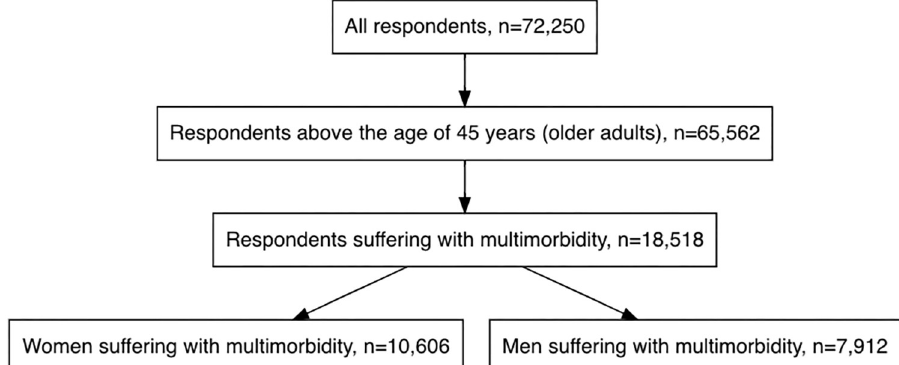
Fig 1. Description of study sample, Longitudinal Aging Study in India,